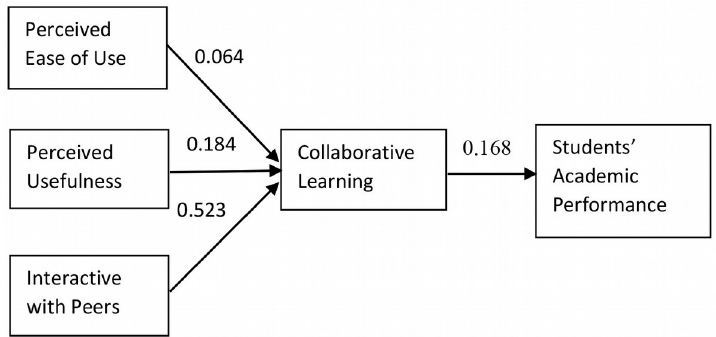
Figure 3. proposed result of the conceptual